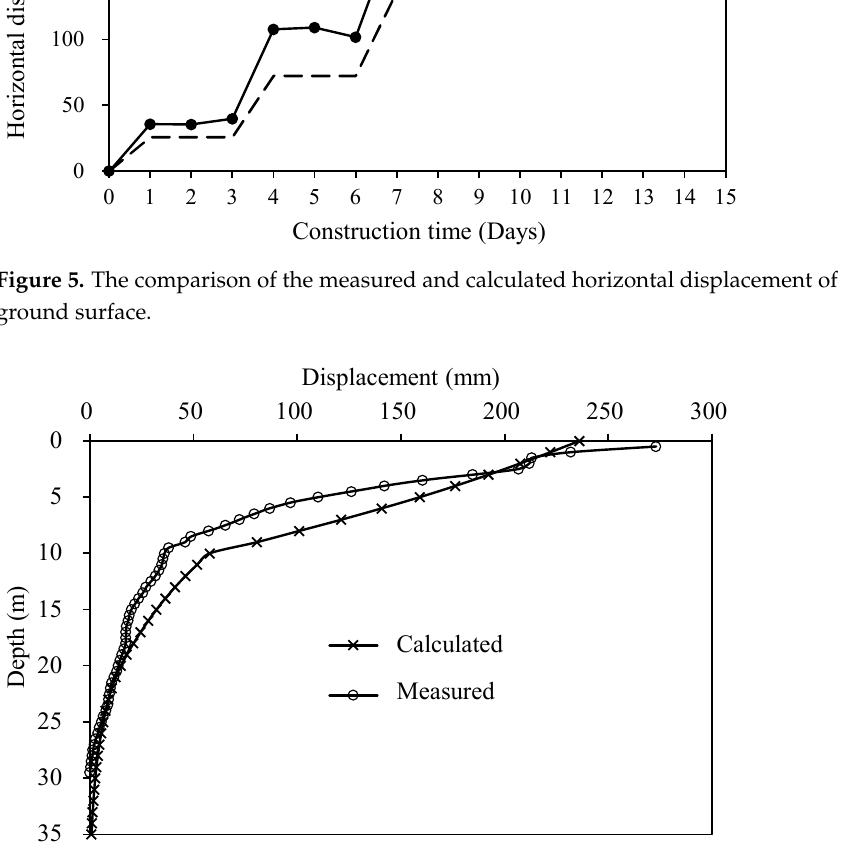
Figure 6. The horizontal displacements along the steel pipe pile obtained by the field test and numerical model.